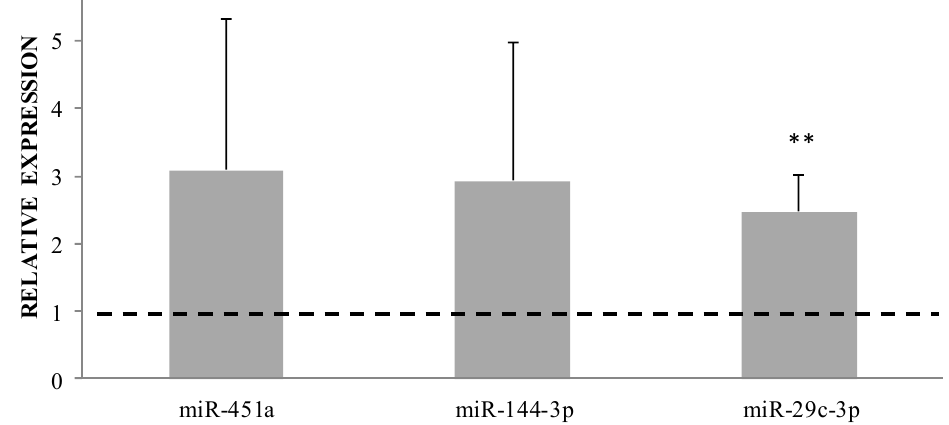
Figure 2. Relative expression of miR-451a, miR-144-3p, and miR-29c-3p (calculated as 2 − ∆∆ C t T4 vs. T0). Values > 1 (dotted line) indicate upregulation, values < 1 indicate downregulation. Parametric t -test ∆ C t T0 vs. T4, ** p < 0.01.